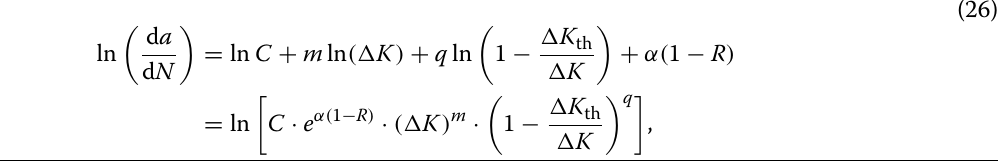
Figure 6 Effect of the x 2 term coefficient on the Al-7055-T7511( R factor versus Δ K , b predicting curves and test data after removing the x 2